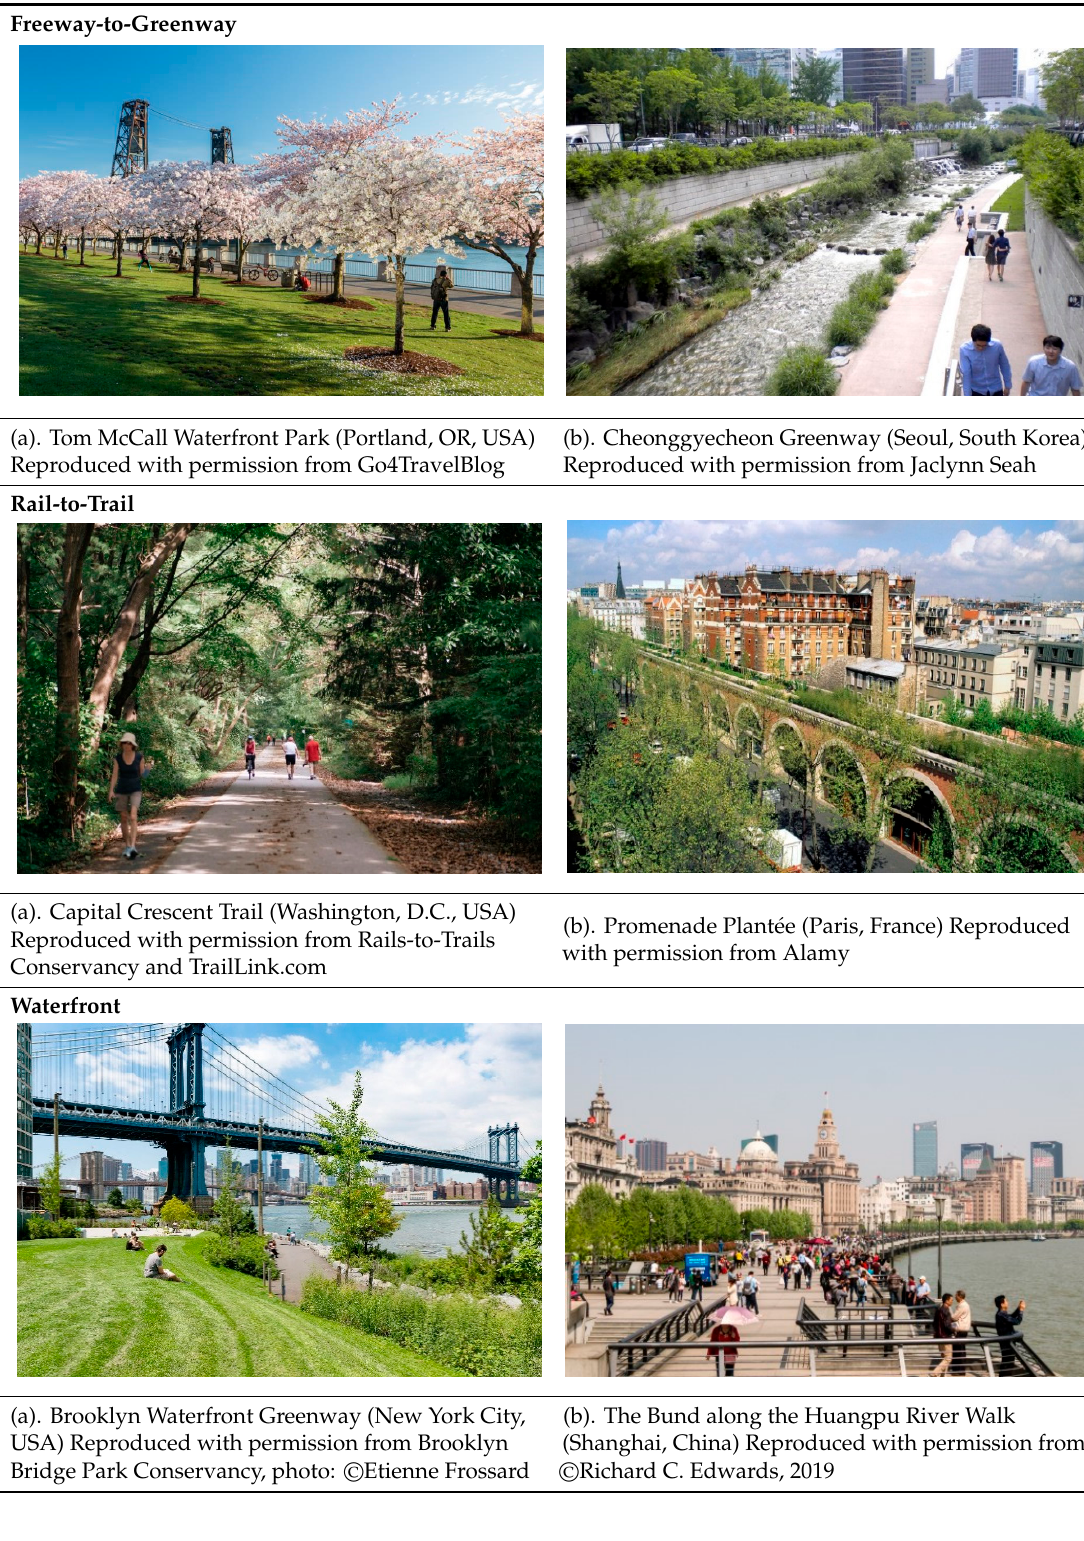
Table 7. Urban greenway typology: photographic examples. Table 7. Greenway typology: photographic examples.